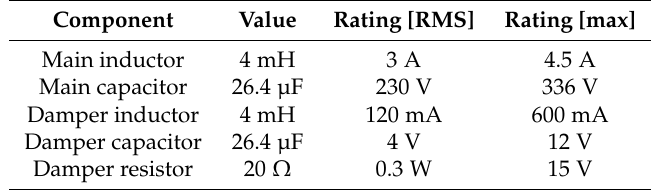
Table 1. Specifications of the input filter. The resulting cut-off frequency is 978